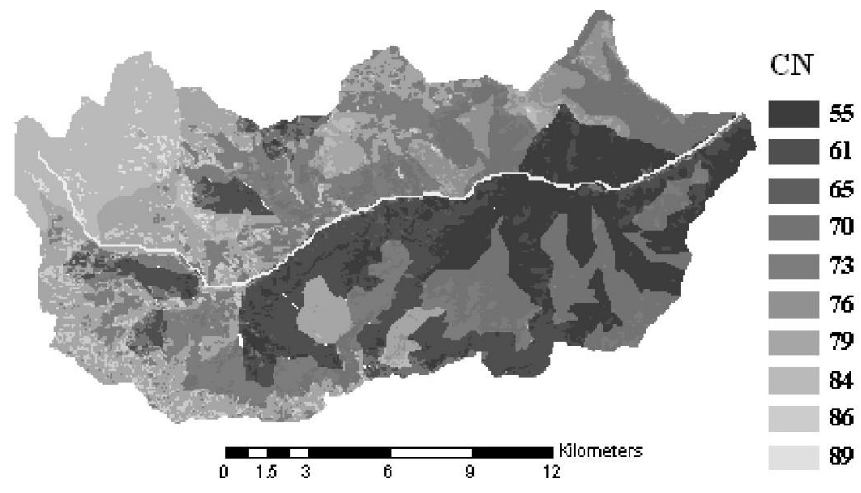
Fig.6. Runoff curve number map